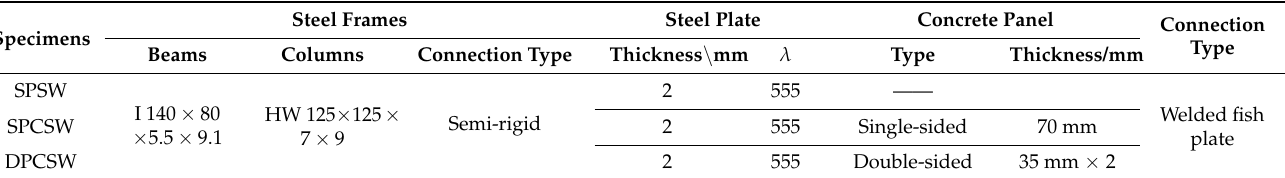
Table 1. Composition of tested